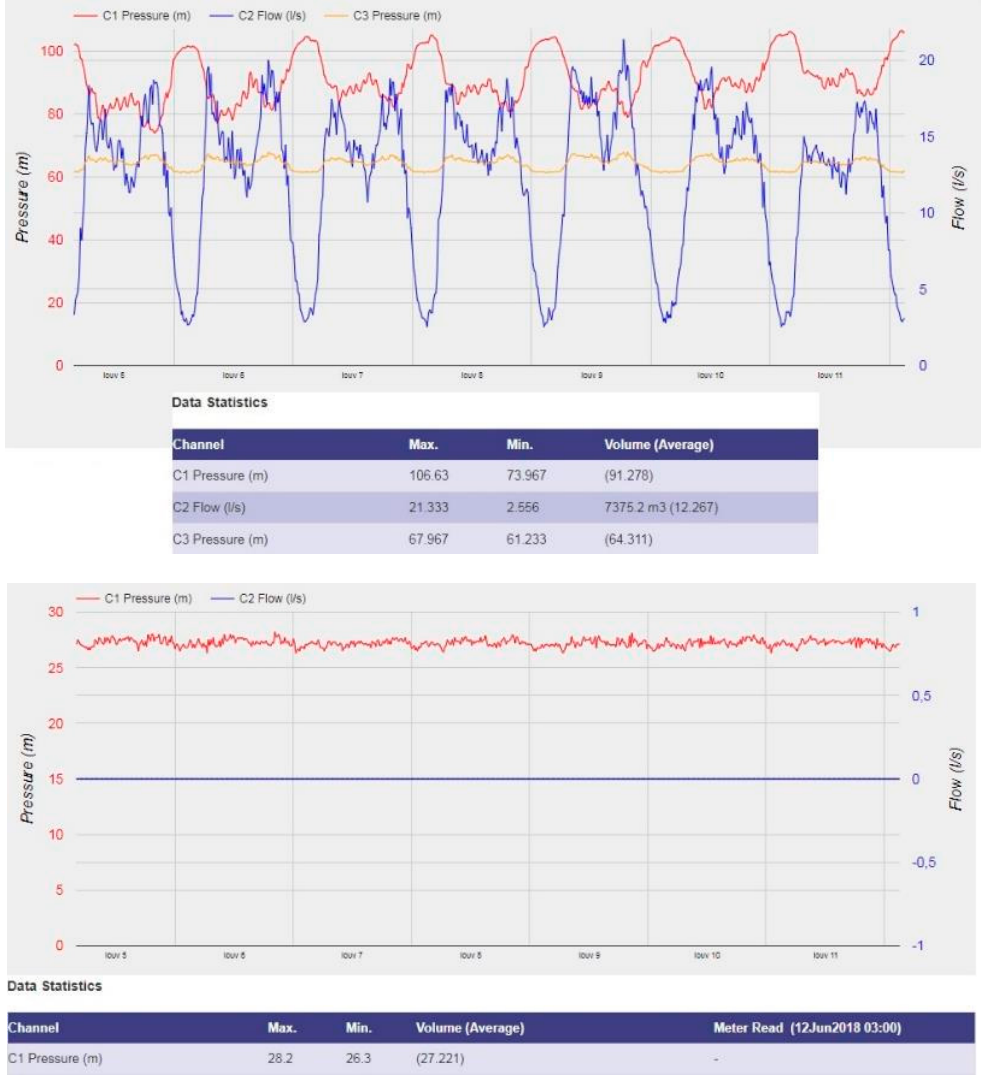
Figure 7. Weekly set of data from the 5th to the 12th of June